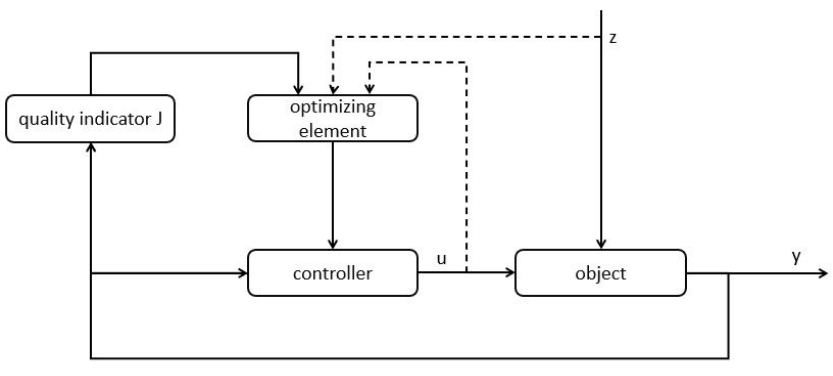
Figure 2. Closed loop extreme control system with optimization of the controller